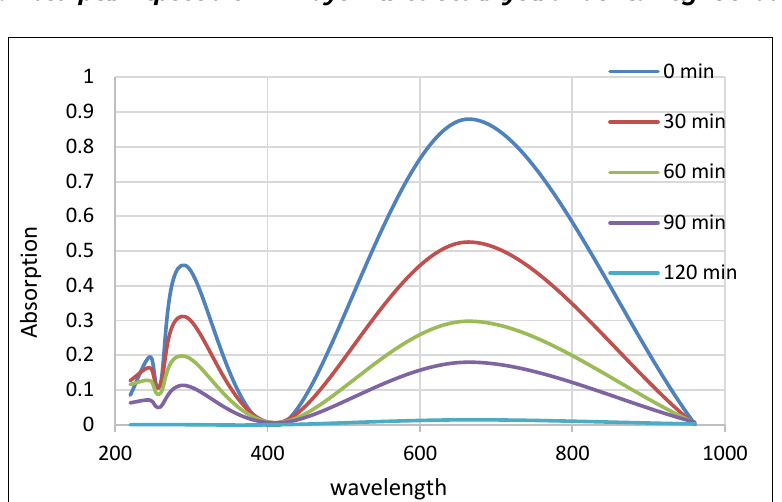
Fig. 7: Absorption spectra of MB solutions with nanostructured ZnO under sunlight